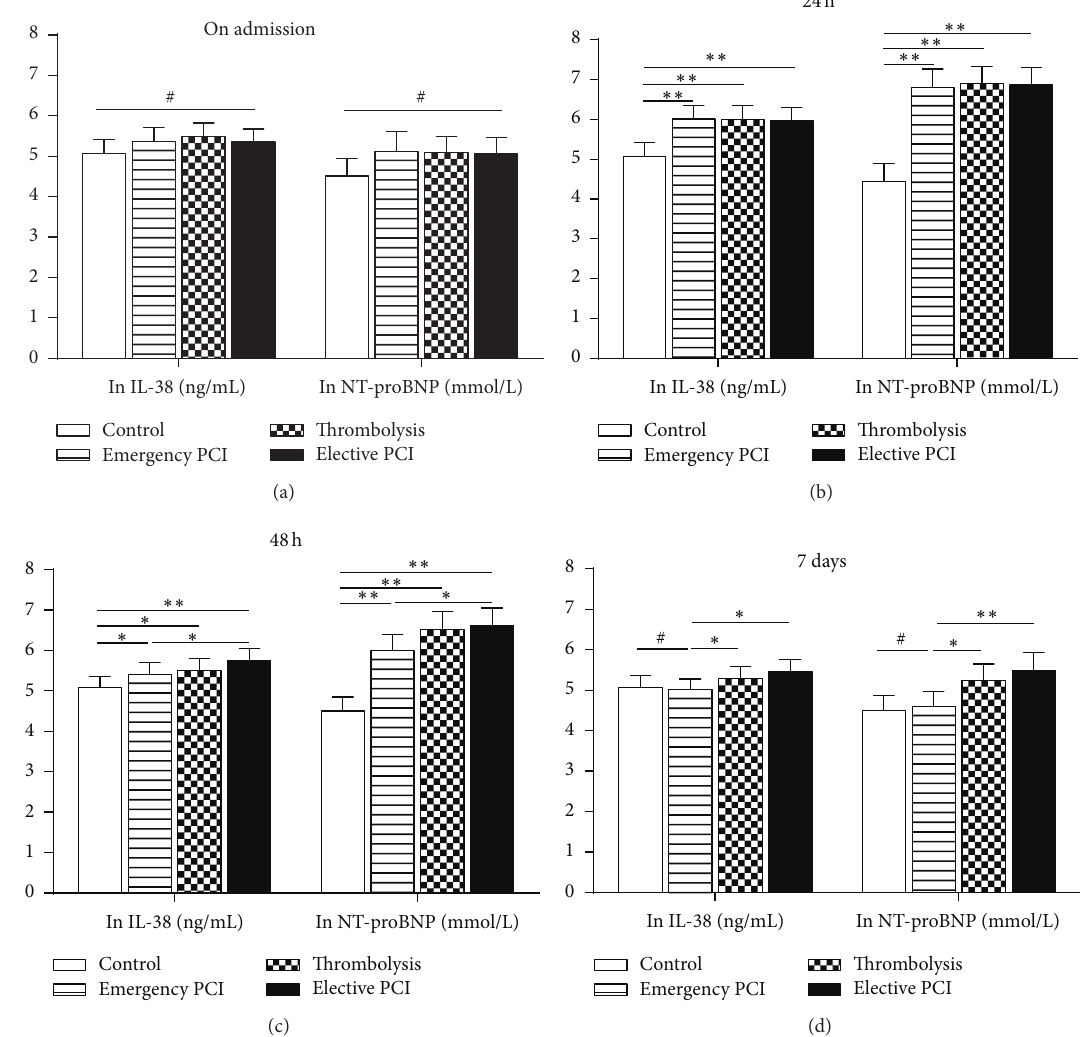
Figure 2: Plasma IL-38 and NT-proBNP from STEMI patients with different reperfusion strategies. IL-38 and NT-proBNP were qualified by ELISA kit in four groups (Control, Emergency PCI, Thrombolysis, and Elective PCI) at different time-points (on admission, 24 h, 48 h, and 7 days). The statistical analysis is performed after ln transformation. Data are presented as mean ± SD. # 𝑃 > 0.05 , ∗ 𝑃 < 0.05 , and ∗∗ 𝑃 < 0.01